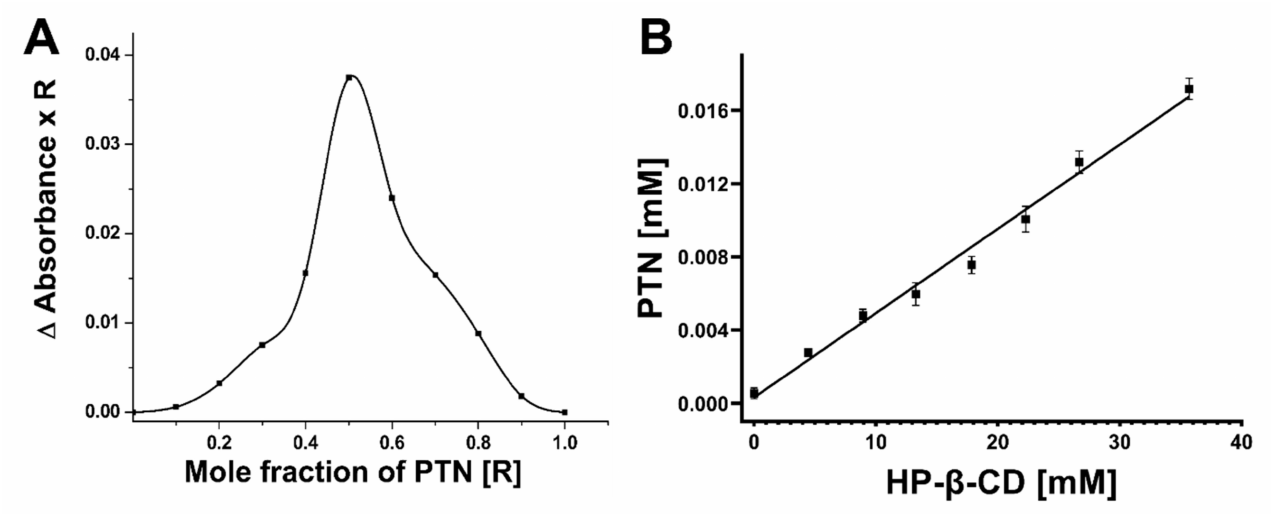
Figure 1. ( A ) Job’s plot for different mole fractions of PTN (R). ( B ) Phase solubility diagram of PTN/HP- β -CD complex system at 25 ◦ C. The concentration of HP- β -CD was in the range of 0–35 mM. All measurements were performed in triplicate, and the values were expressed as means ± SDs ( n =